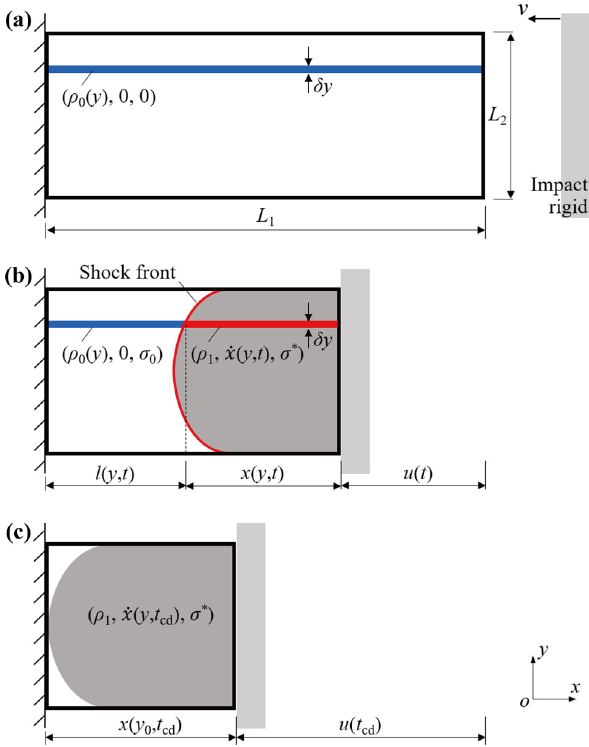
Figure 9: One - dimensional shock model for gradient Voronoi structure: ( a ) uniaxial impact compression model, ( b ) at time t , and ( c ) at time t cd